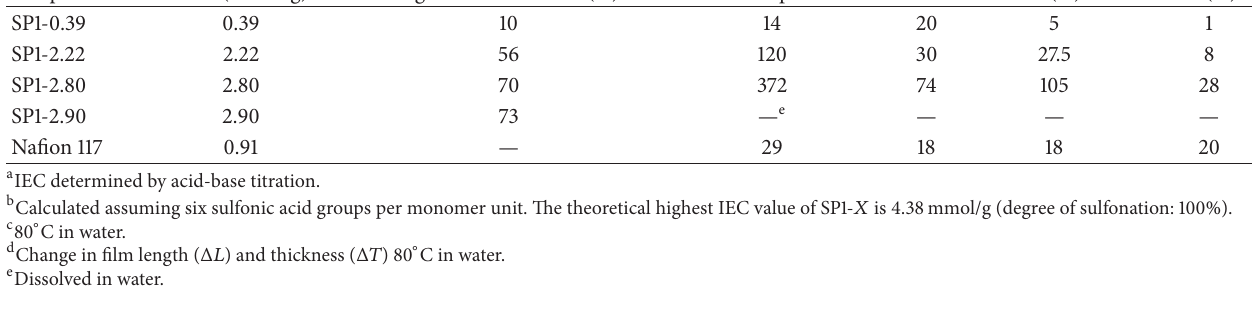
Table 2: Proton conductivity and stability of SP1 membranes.